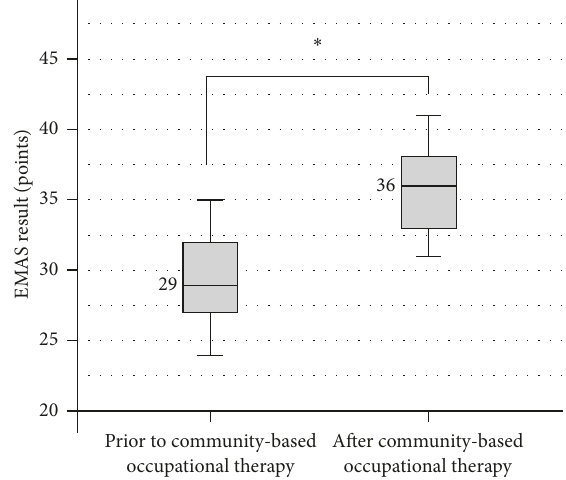
Figure 1: Changes in the engagement in meaningful activities in the experimental group participants, ∗ 𝑝 = 0.005